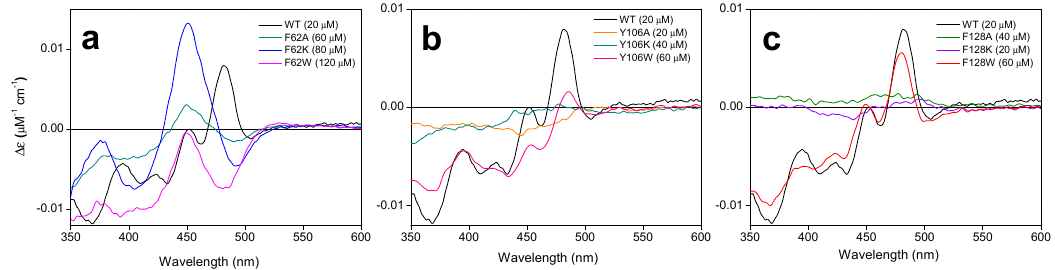
Figure 6. Internalization of the isoalloxazine ring of FAD in Ca FADS variants. Visible difference spectra elicited with ( a ) F62, ( b ) Y106, and ( c ) F128 Ca FADS variants (4–6 μ M) upon titration with saturating FMN concentrations (indicated in parenthesis for each variant). In all panels, the difference spectrum of WT is included for comparison. Specstra recorded in 20 mM PIPES, 10 mM MgCl 2 , pH 7.0 at 25 °C.